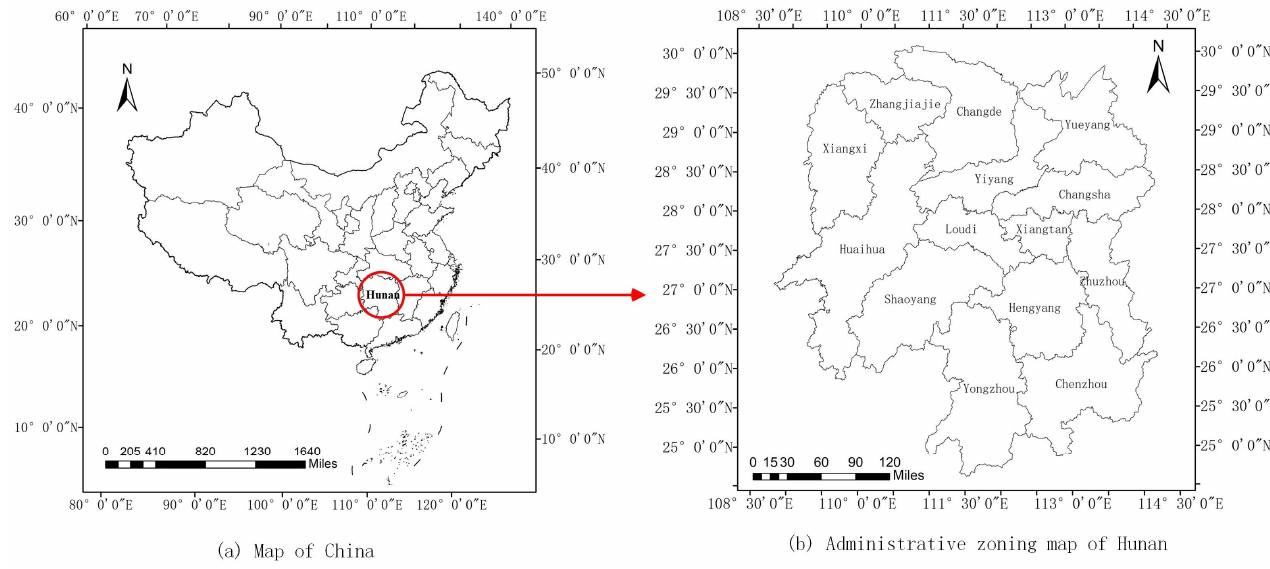
Figure 1. Schematic diagram of study area.